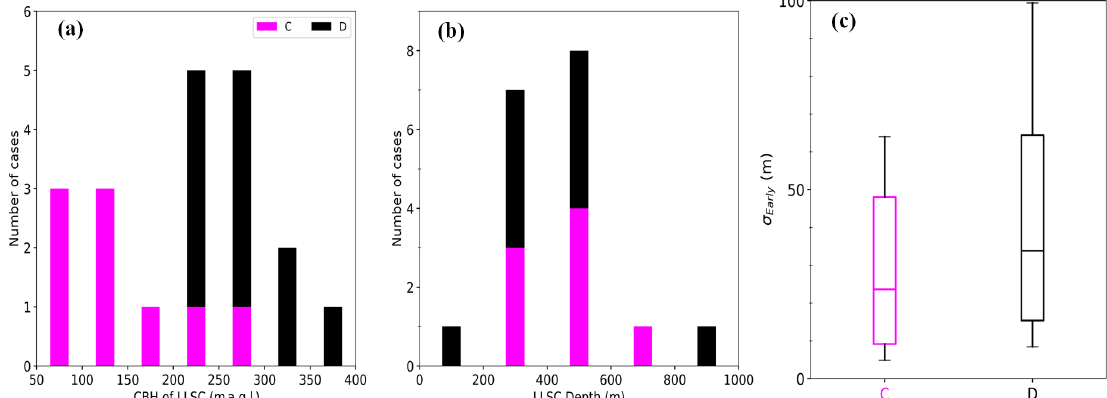
Figure 6. Statistics on the LLSC macrophysical characteristics at the end of the stratus phase performed on the 20 cases (the 9 C cases and 11 D cases out of 13) for which the LLSC is present (CF ≥ 90%) over at least 70% of the time between 04:00 and 06:30UTC on day- D + 1. Distributions of LLSC base height (CBH; a ) are the same as in Fig. 3, and depth (b) is calculated by using the median value between 04:00 and 06:30UTC of cloud-radar-estimated CTHs as the LLSC summit. The depth was not estimated for 2 cases (one C and one D) out of 20 due to missing CTH data. Statistical information on σ Early (c) , which is the median value between 04:00 and 06:30UTC of diagnostic parameter σ ∗ , measuring the LLSC base homogeneity. The edges of the boxes represent the 25th, median and 75th percentiles, and the whiskers represent the minimum and maximum values. C and D stand for coupled and decoupled LLSC,